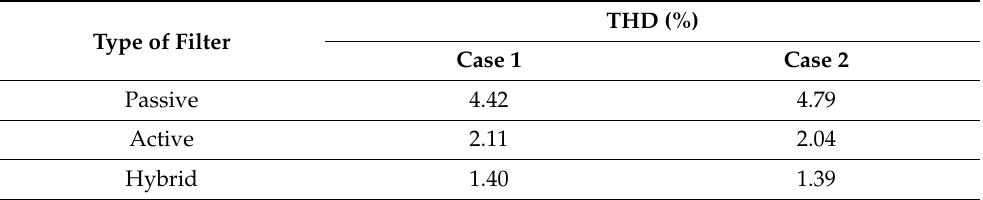
Table 1. Comparative performance of THD using various filters.